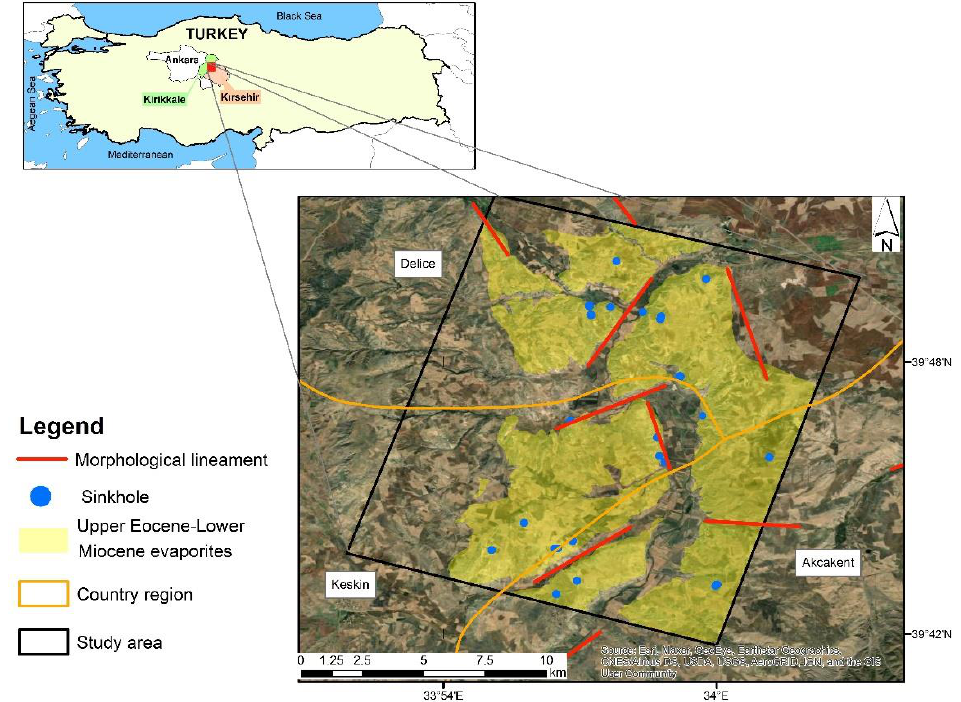
Figure 1. Location and extent of the investigation, simplified geology (after Donmez et al. [31]), and sinkhole inventory of the study